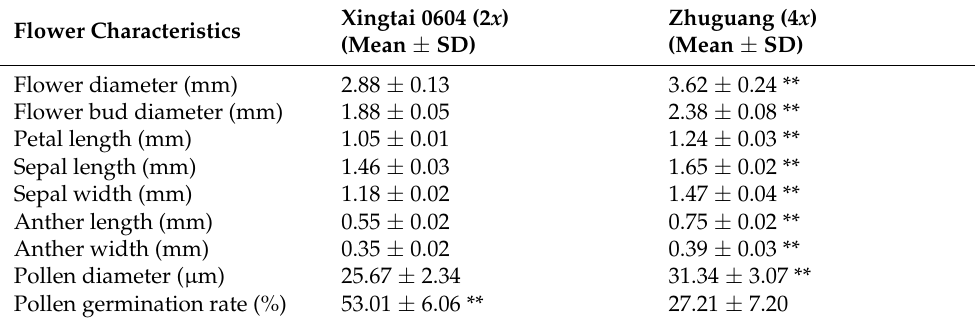
Table 2. Flower characteristics of ‘Xingtai0604 (cid:48) and ‘Zhuguang’. Flower Characteristics